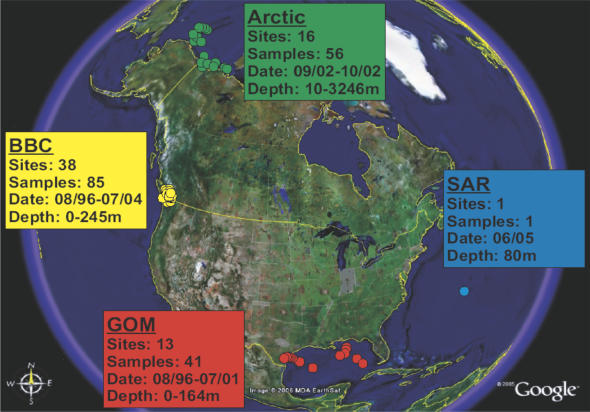
The authors used metagenomics to analyze the “viromes” of oceanic viruses and shed light on their diversity, distribution, and ecosystem impact in four ocean regions around the world.